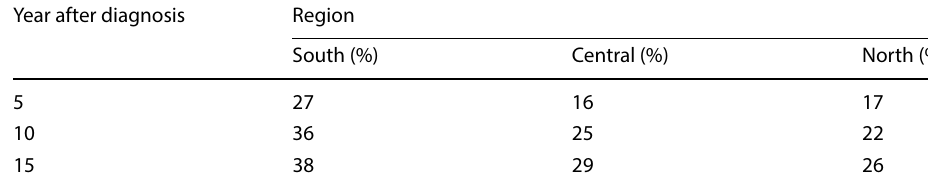
Table 3 Cumulative incidence of uveal melanoma-related